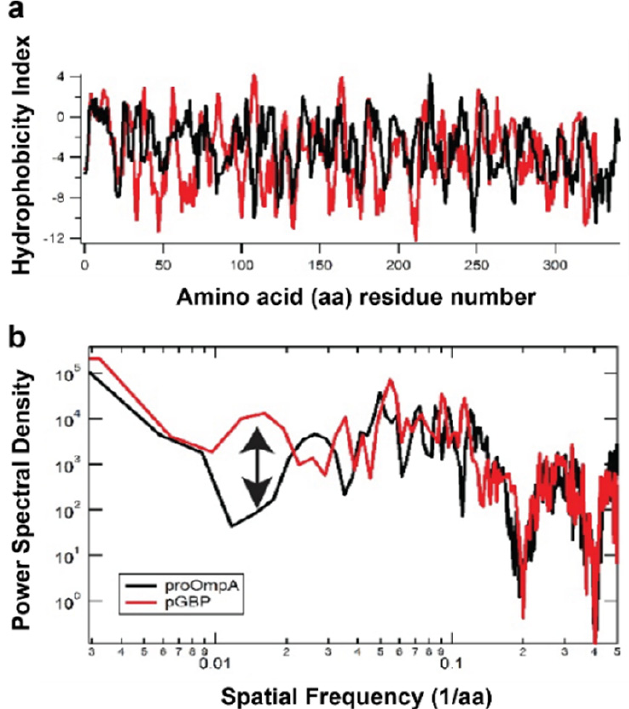
Figure 12. A distinction between pOmpA and pGBP in the periodicity of hydrophobicity. ( a ) Tradi- tional hydrophobicity plots for pGBP (red) and pOmpA (black). ( b ) Fourier transform of hydropho- bicity shows overall agreement between the two precursor species except around a spatial frequency of 0.017 1/aa (arrow).